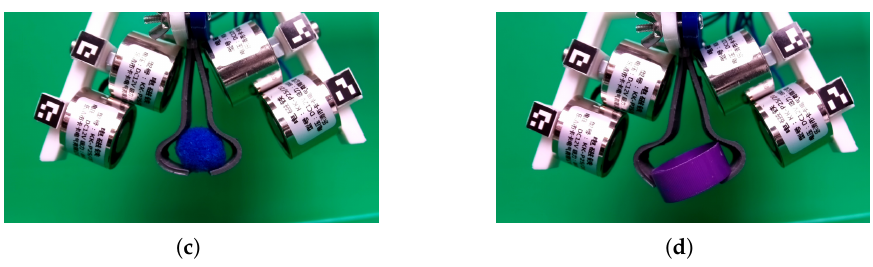
Figure 16. The soft gripper holding various objects: wood ball ( a ), game pawn ( b ), pompon ( c ), pencil sharpener ( d